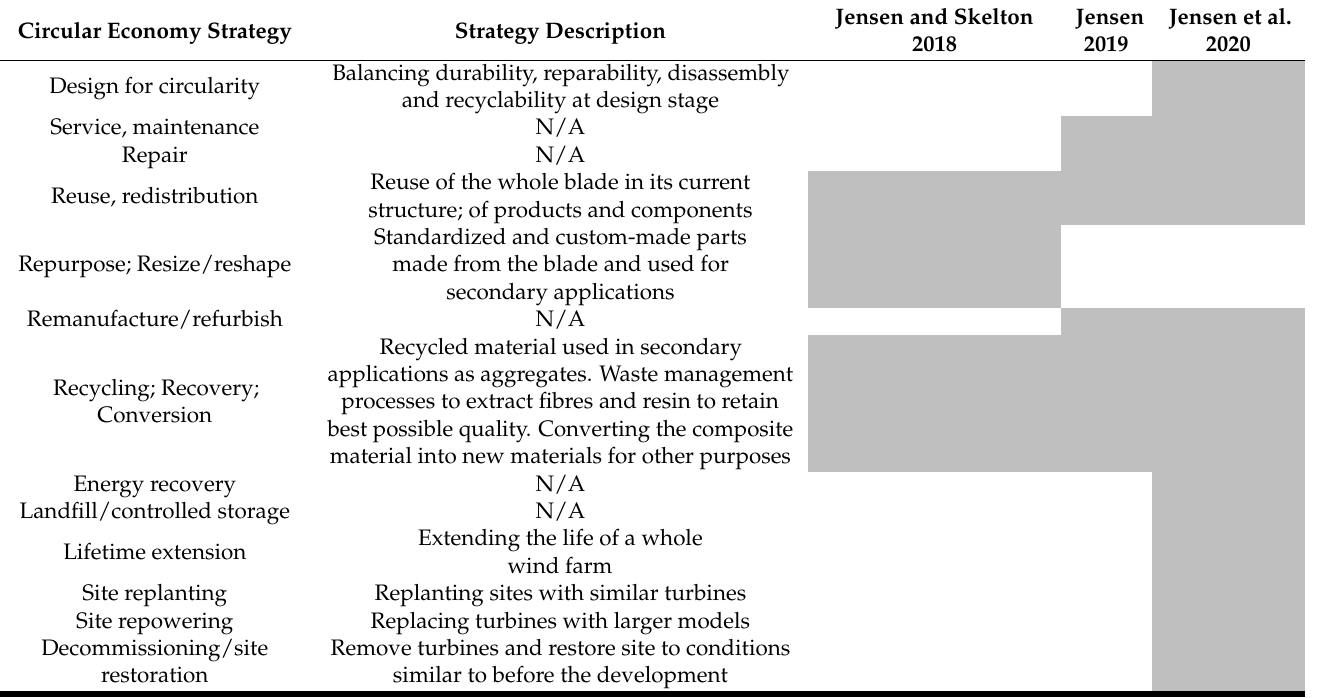
Table 1. Initial circular economy framework for offshore wind based on the scientific literature [8,47,48]. Grey cells indicate the initial frameworks that named the circular economy strategies. “N/A” indicates that descriptions of named strategies were missing in the